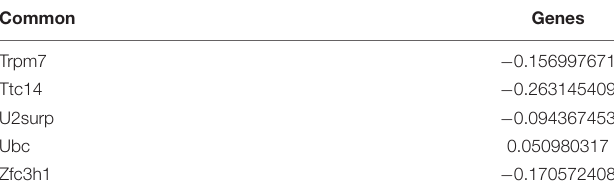
TABLE 2 | Common deregulated genes in TM4 and GC-1 after radiation